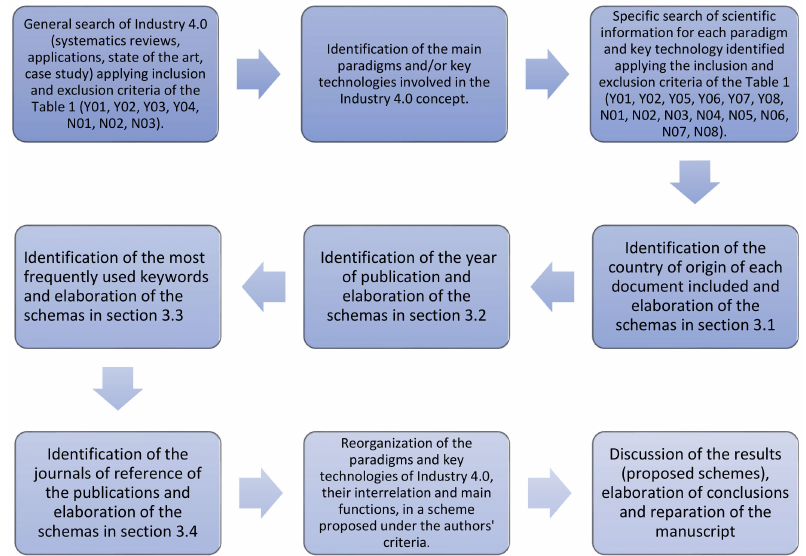
Figure 1. The main steps taken to validate the research.